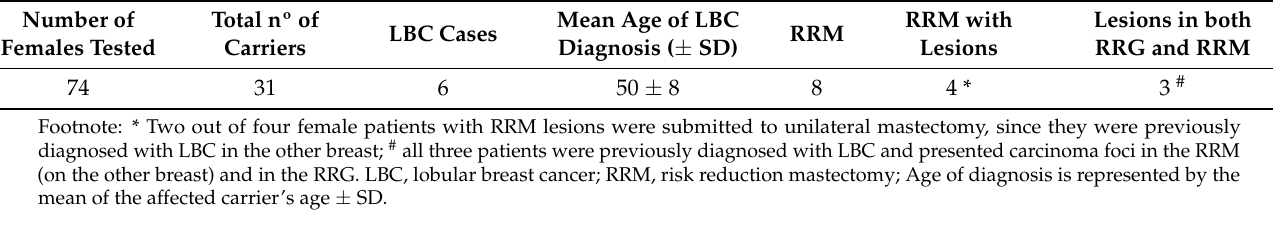
Footnote: * One out of seven females presented DGC and LBC; # from 13 females bearing lesions in RRG, 3 also presented LBC. DGC, diffuse gastric cancer; RRG, risk reduction gastrectomy; LBC, lobular breast cancer; Age of diagnosis is represented by the mean of the affected carrier’s age ± SD. Table 2. Overview of breast-related clinical presentations in CDH1 c.1901C>T variant carriers from nine HDGC families. Number of Total nº of Females Tested